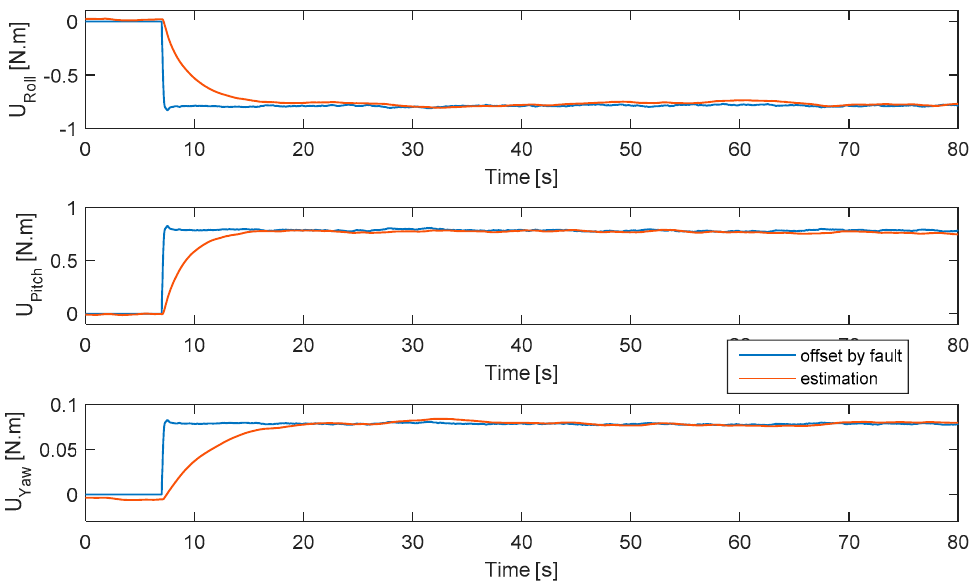
Figure 8. Controller output offset by fault and its estimation.